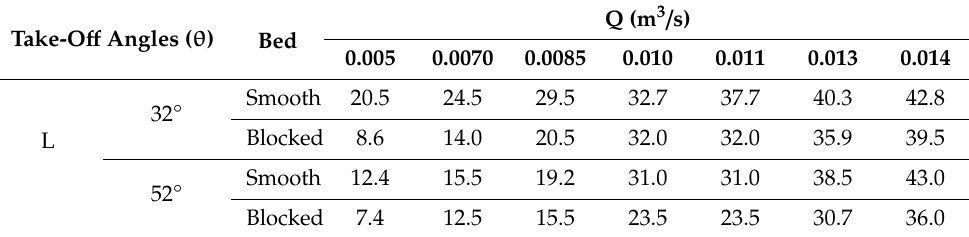
Figure 12. Difference in jet length in smooth and block beds. Bucket with ( A ) θ = 32° and ( B ) θ = 52°. Equations (15) and (16) allow for the prediction of relative energy dissipation and jet length. Equations were developed on the basis of the 70–30% rule for experimental and numerical results. In this method, 70% of the data were used to train the coefficients, and the remaining 30% were used to test correlation accuracy: